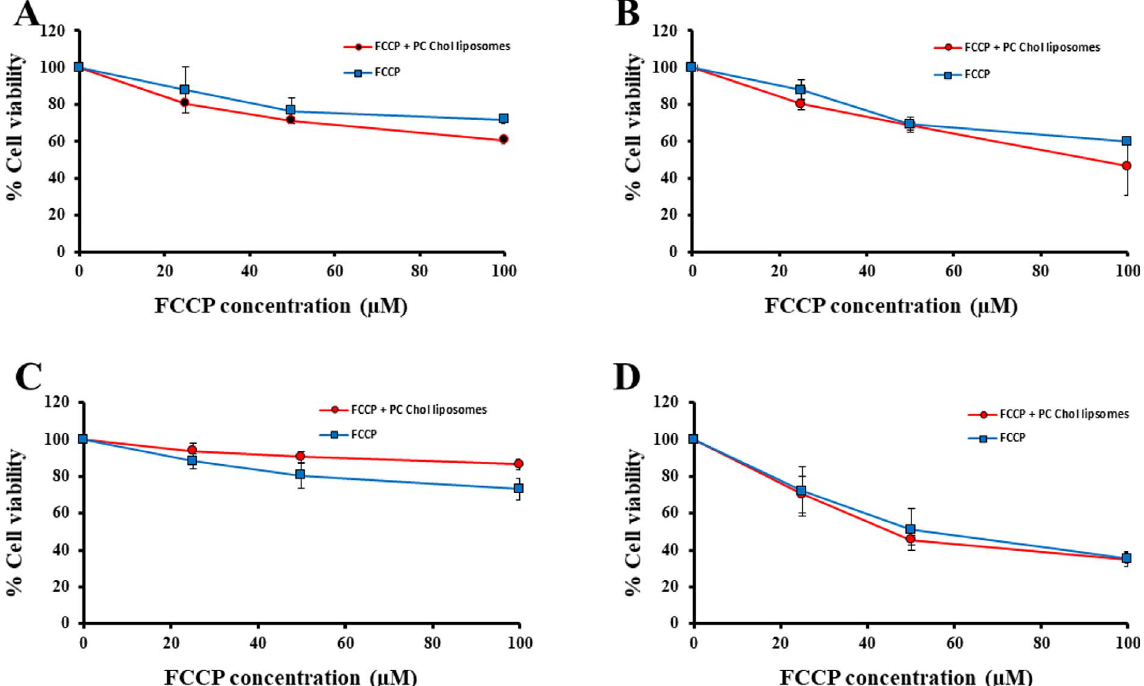
Figure 4. Quantitative determination of FCCP toxicity in human ovarian carcinoma and human lung carcinoma cells. Percent cell viability in A : A2780 cells, B : Ovcar3 cells, C : A549 cells, D : H69/AR cells exposed to either FCCP in DMSO or FCCP in DMSO with PC: Cholesterol liposomes for 4 h at indicated concentrations of FCCP. Values represent mean ± standard deviation from three independent